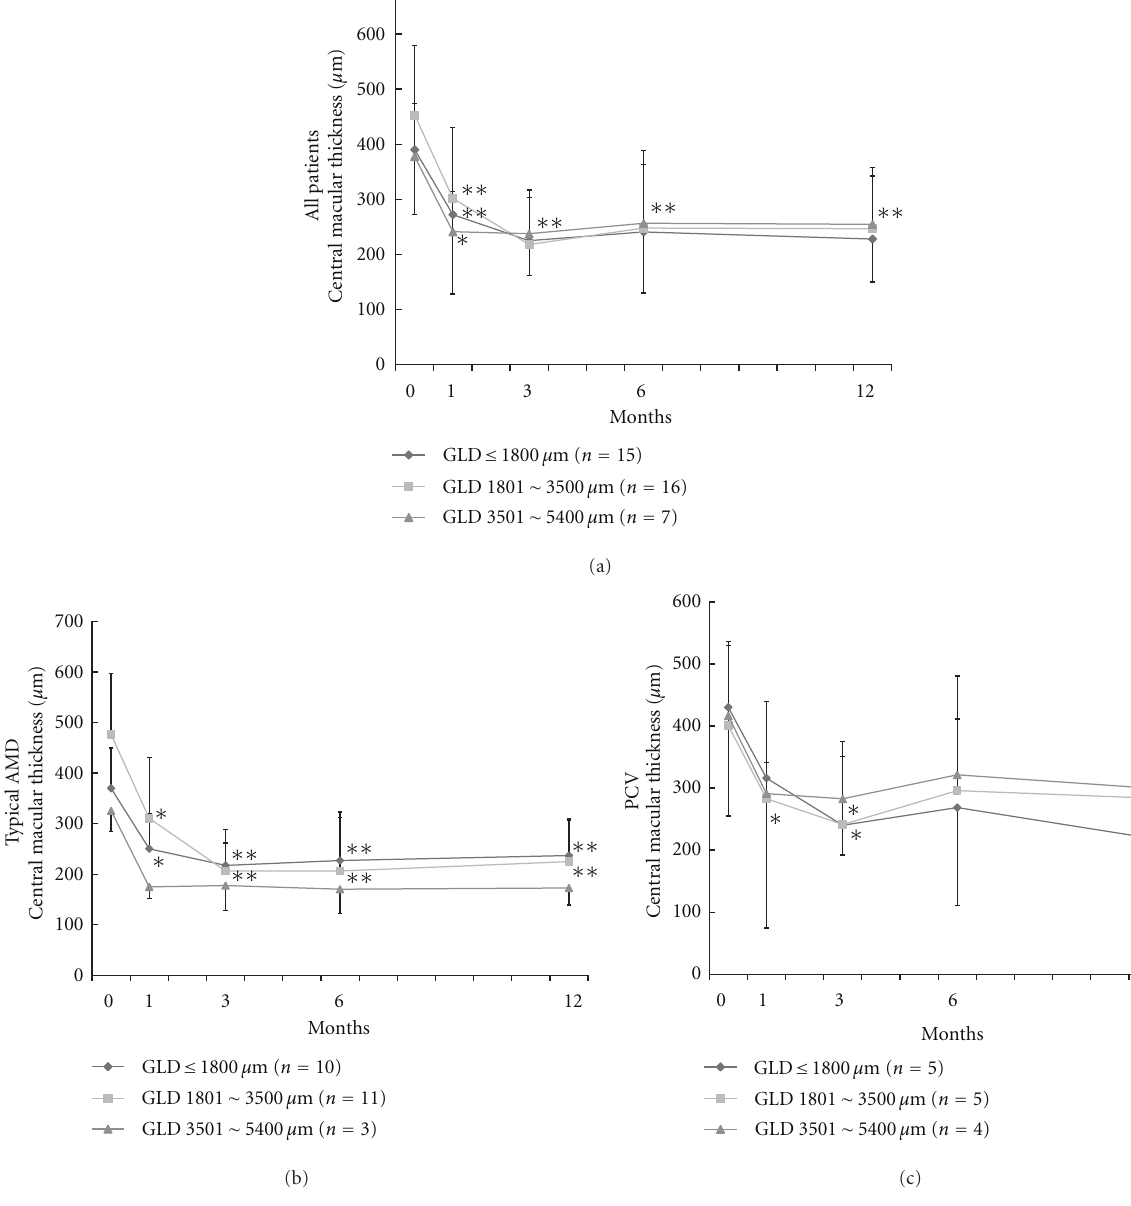
Figure 2: Changes in mean central macular thickness (CMT). (a) Mean CMT of all 38 patients in three GLD groups; GLD (cid:2) 1800 µ m, GLD between 1801 and 3500 µ m, and GLD between 3501 and 5400 µ m. All 3 groups showed similar values among the 3 groups at all time points. (b) Mean CMT of typical AMD of 24 patients. (c) Mean CMT of PCV of 14 patients in 3 GLD groups. There was no significant di ff erence among the three groups ( P > 0 . 05). Bars indicate standard deviations. ∗ P < 0 . 05, ∗∗ P < 0 . 01; P value for comparison between baseline and each visit. AMD: age-related macular degeneration, GLD: greatest linear dimension. PCV: polypoidal choroidal